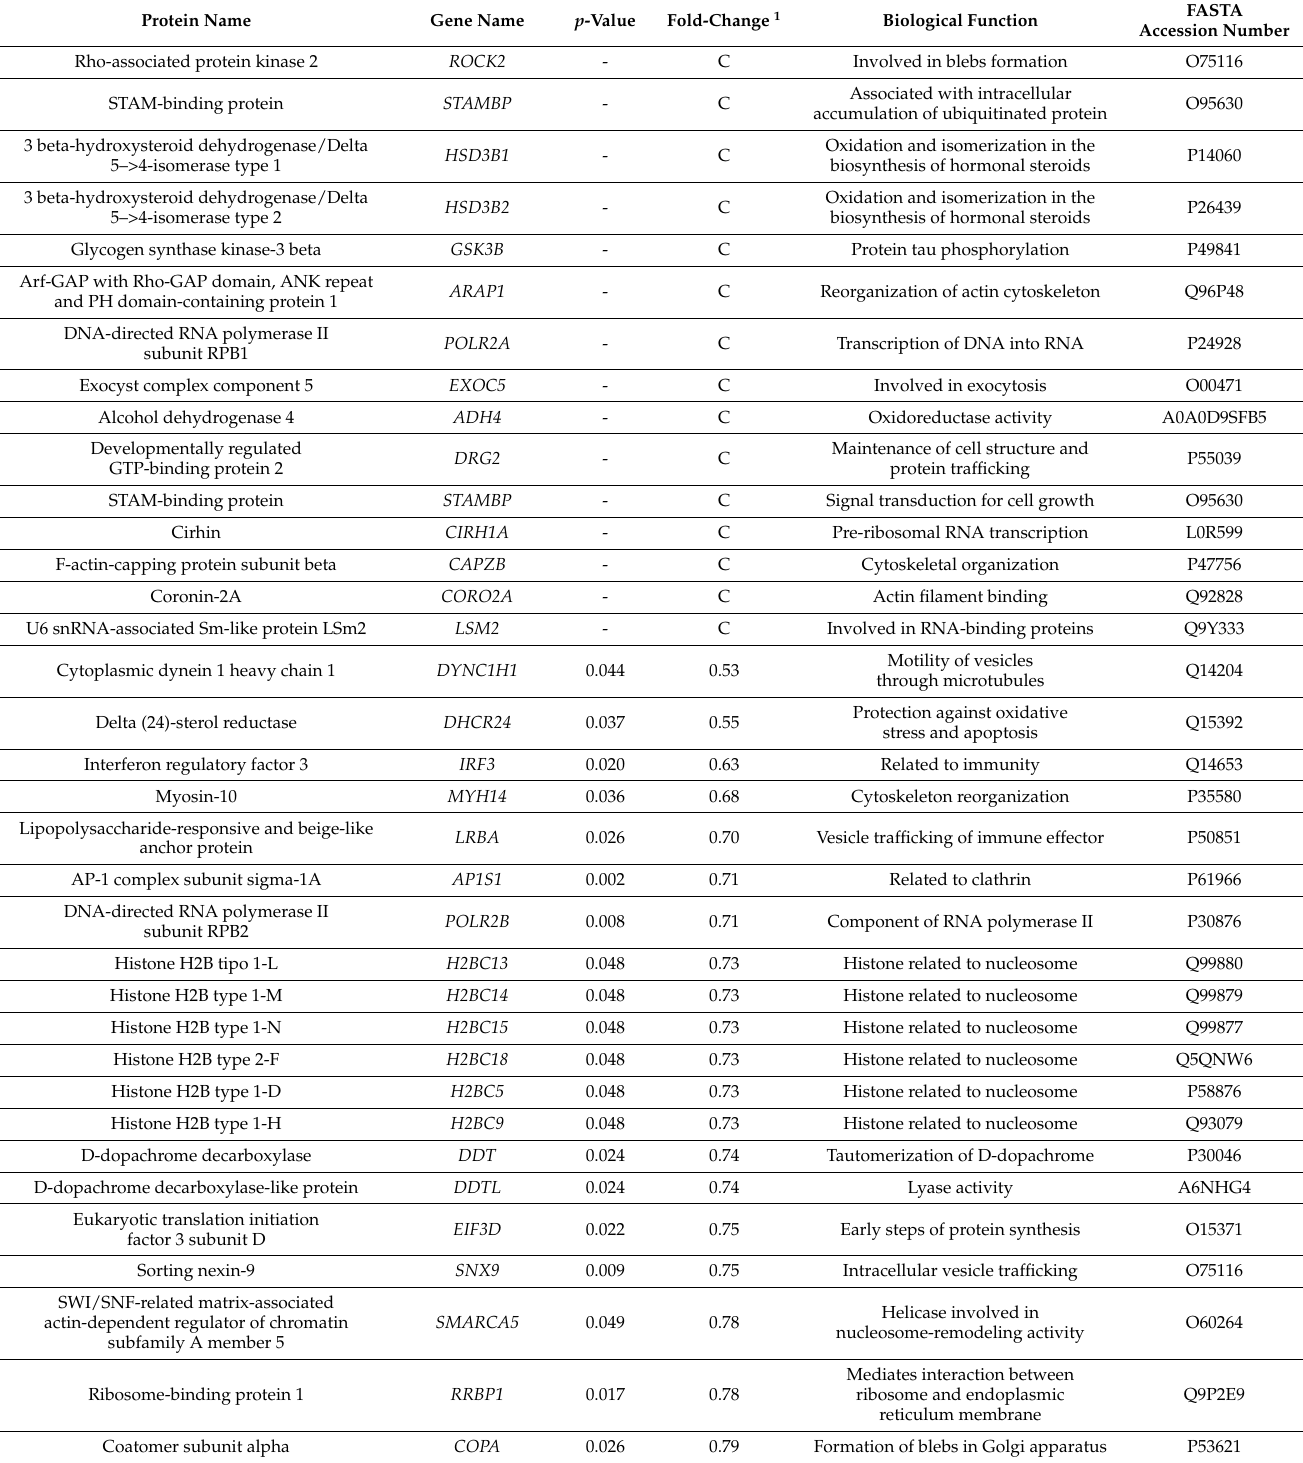
Table 1. Proteins from differentiated human enterocytes affected by the exposure to 200 µ M 3- nitrotyrosine for 72 h in comparison to the non-treated control